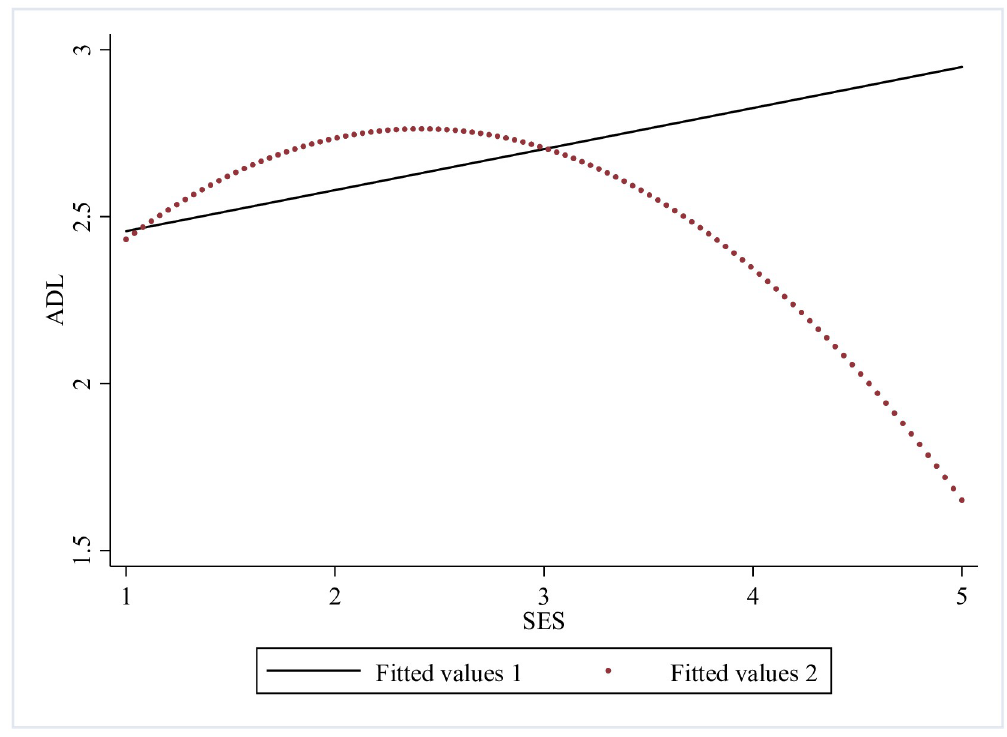
Fig 1. Fitting relationship between SES and ADL